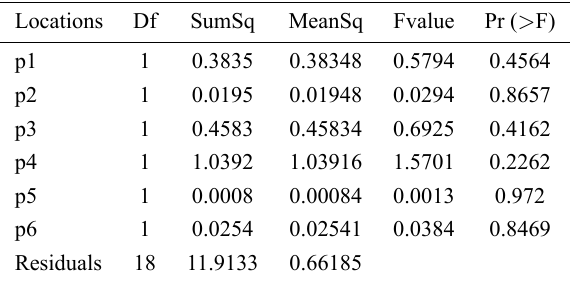
Table 5. ANOVA effect of wrestlers sports level on location of weak links in low threshold